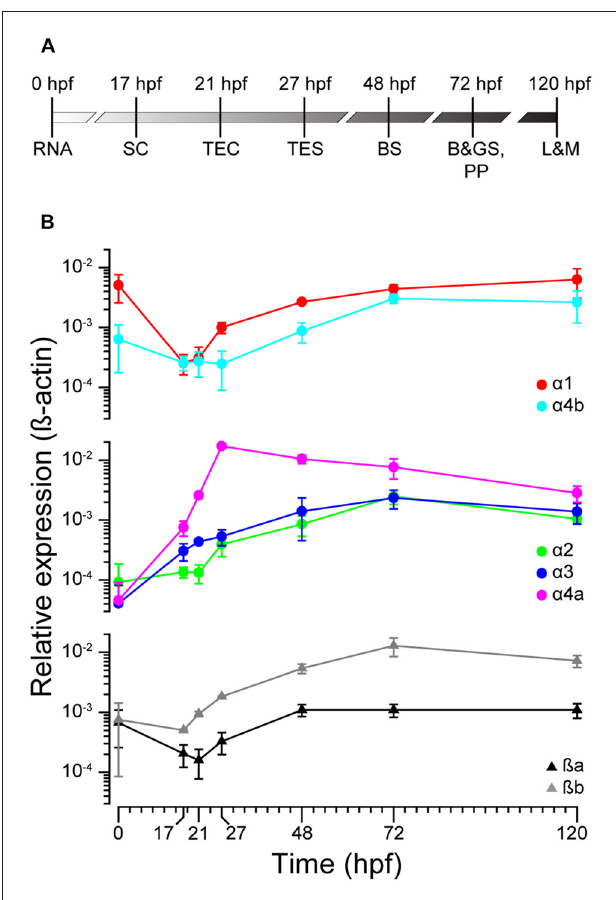
FIGURE 2 | zGlyR subunits show variable expression during development. (A) Timeline highlighting the developmental stages examined. RNA, inheritance of maternal RNA; SC, spontaneous coiling; TEC, touch-evoked coiling; TES, touch-evoked swimming; BS, burst swimming; B&GS, PP: beat and glide swimming, prone position; L&M, learning and memory. (B) Expression of zGlyR subunits over time determined by qPCR. Each subunit’s expression level was normalized against b-actin. Values represent the average ± SEM of nine samples from three different mating pairs.